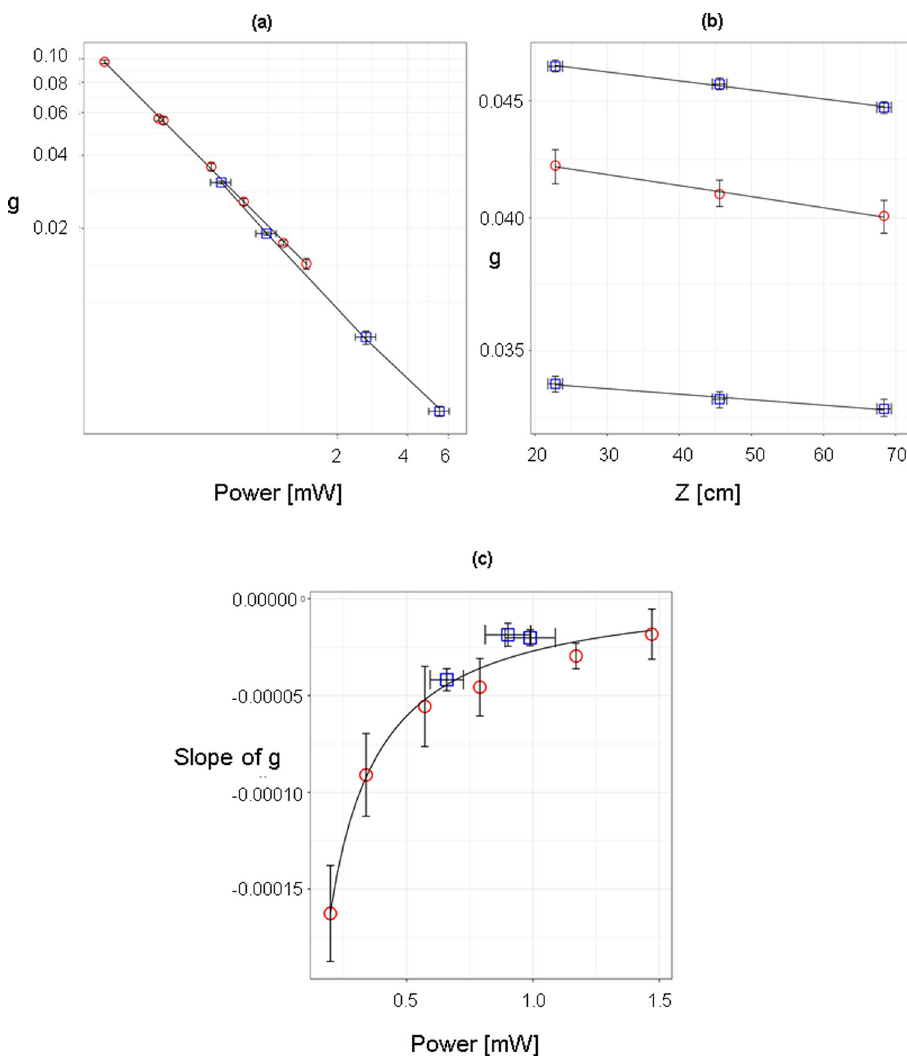
Fig. 5 Measurements of the spatial correlations affecting the neutron population within the Reactor Critical Facility (RCF). a Spatial correlation function g versus reactor power P on a log – log scale using the two NoMAD detectors (simulations: red circles; RCF experiments: blue squares; theory: 1/ P fi t). The spatial correlations vanishes as 1/ P , coherently with the predictions of spatial clustering models. b Spatial correlation function g versus distance z on a lin – lin scale using the inner 3 He tubes, for various reactor power levels. Simulated (red circles, for P = 0.79 mW) and experimental (blue squares, bottom curve P = 0.63 mW, top curve: P = 0.99 mW) data are fi tted using a linear function predicted by the theory. The typical spatial linear decay of the correlation function signs a clustering effect of the neutron population in the presence of intrinsic sources. c Axial gradient of the spatial correlation function ∂ z g versus distance z on a lin – lin scale using the inner 3 He tubes (simulations: red circles; RCF experiments: blue squares; theory: − 1/ P fi t). The neutron clusters sizes are inversely proportional to the reactor power. Statistical error bars on the g and its slope ∂ z g are estimated using the bootstrapping method, both for simulated and experimental data. Relative errors on the power estimation of experimental data were overestimated at 10%, using the detectors calibration, and error bars on the positioning in z of 3 He detectors have been evaluated to be approximately of 1